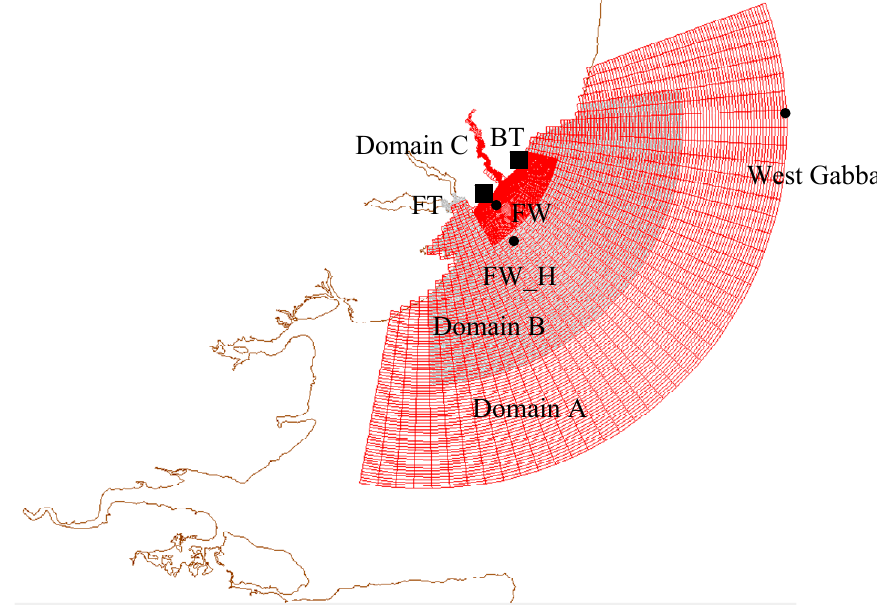
Figure 9. Nested domains of the Delft3D Deben wave and tidal model and validation points in this study. The rectangular points stand for the tide validation locations and circles are wave validation locations. Detailed descriptions and validations can refer to [27]. Adapted with permission from ELSEVIER, 2019.